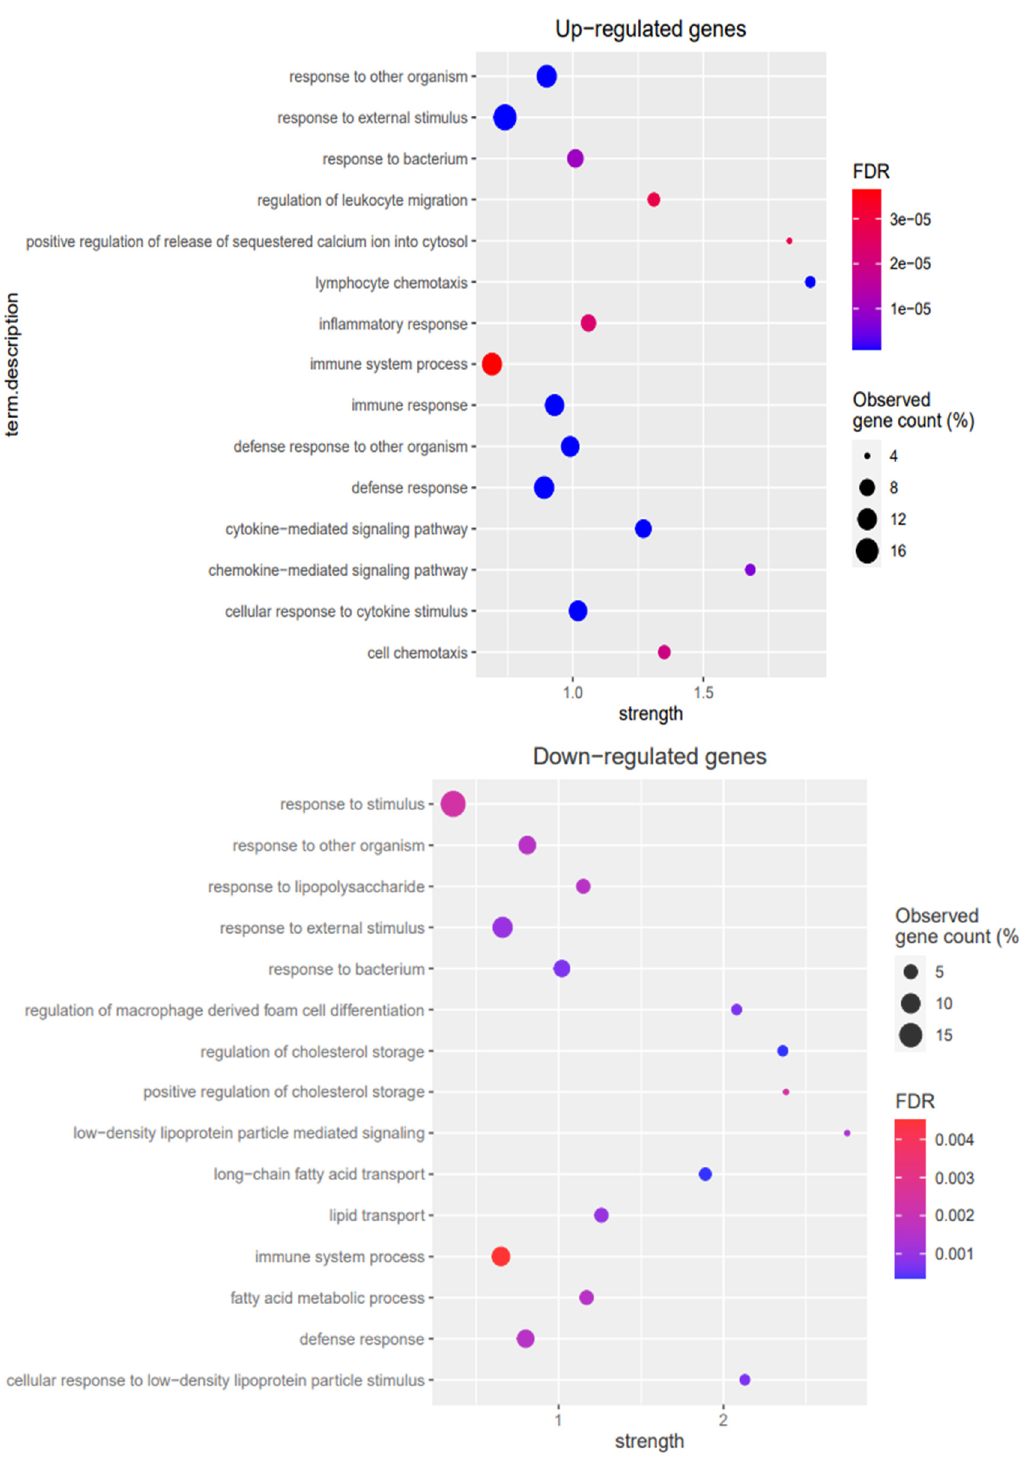
Figure 3: Bubble plot of the GO analysis of DEGs. The top 20 items of ’biological process’ in upregulated genes (upper panel) and downregulated genes (lower panel) were displayed with the parameters strength and − log10 p -value. Strength: Log10 (observed/expected). This measure describes how large the enrichment effect is. It is the ratio between (i) the number of proteins in your network that are annotated with a term and (ii) the number of proteins that we expect to be annotated with this term in a random network of the same